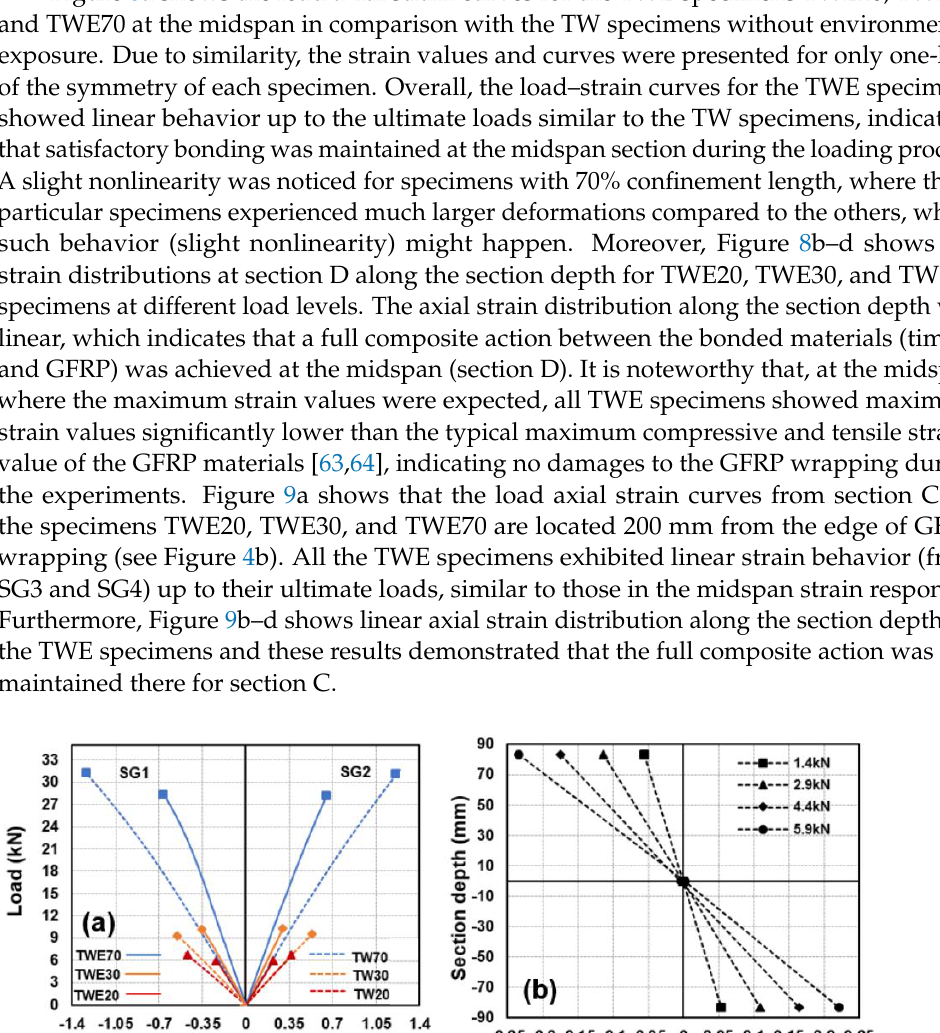
Figure 9. Strain responses at section C. ( a ) Load – strain responses for TWE specimens; ( b ) strain distribution along depth for TWE20; ( c ) strain distribution along depth for TWE30; and ( d ) strain distribution along depth for TWE70.